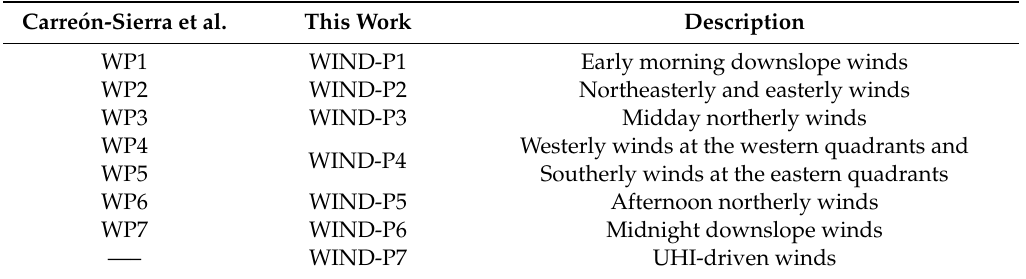
Table 3. Comparison against the wind patterns reported by Carre ó n-Sierra et al. [25]. Carre ó n-Sierra et al. This